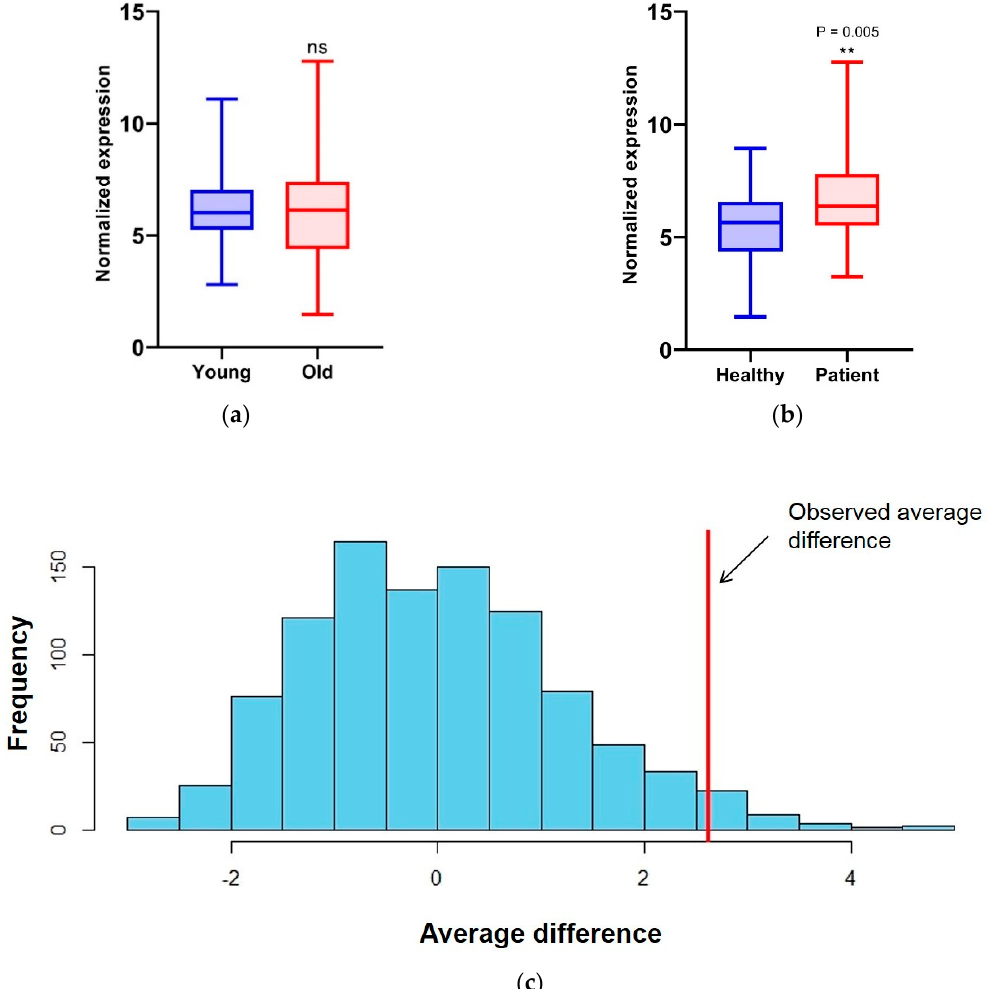
Figure 3. Splicing factors are differentially abundant in healthy and breast cancer patients. ( a,b ). RNA was extracted from the cell-free saliva of 36 healthy and 31 breast cancer patients. Real-time PCR was conducted for HNRNPA1, HNRNPA2B1, HNRNPA3, HNRNPK, HNRNPK exon 8 inclusion, PTBP1 and SRSF6 and normalized to PPIA. Relative expression levels were summed and plotted. Thirty-six healthy and 31 breast cancer patients were pooled together and divided based on age — to “young” and “old” groups. Relative expression levels were summed and plotted ( a ). Healthy and 31 breast cancer groups were plotted ( b ). ( c ) Splicing factor abundance in a sub-group of patients treated with avastin ( n = 3) were compared to the remaining group of patients by permutation testing (1000 times).